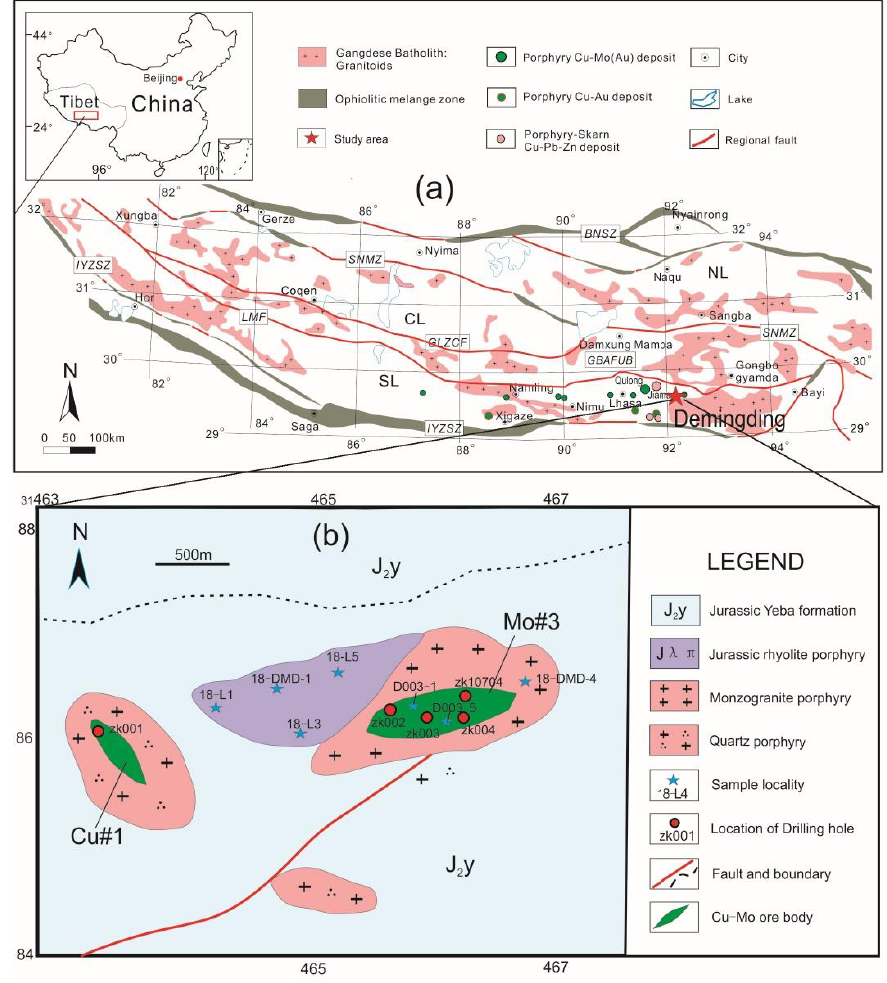
Figure 1. ( a ) Simplified geologic map of the Lhasa terrane showing the distribution of main porphyry deposits and locality of the study area (modified after [22,33]). Abbreviations: BNSZ = Bangong– Nujiang suture zone, SNMZ = Shiquan River-NamTso M é lange Zone, LMF = Luobadui-Milashan Fault, IYZSZ = Indus-Yarlung Zangbo Suture Zone, SL = southern Lhasa Terrane, CL = central Lhasa Terrane, NL = northern Lhasa Terrane. ( b ) Geological sketch map of the Demingding porphyry deposit showing the porphyry intrusion and locations of samples.